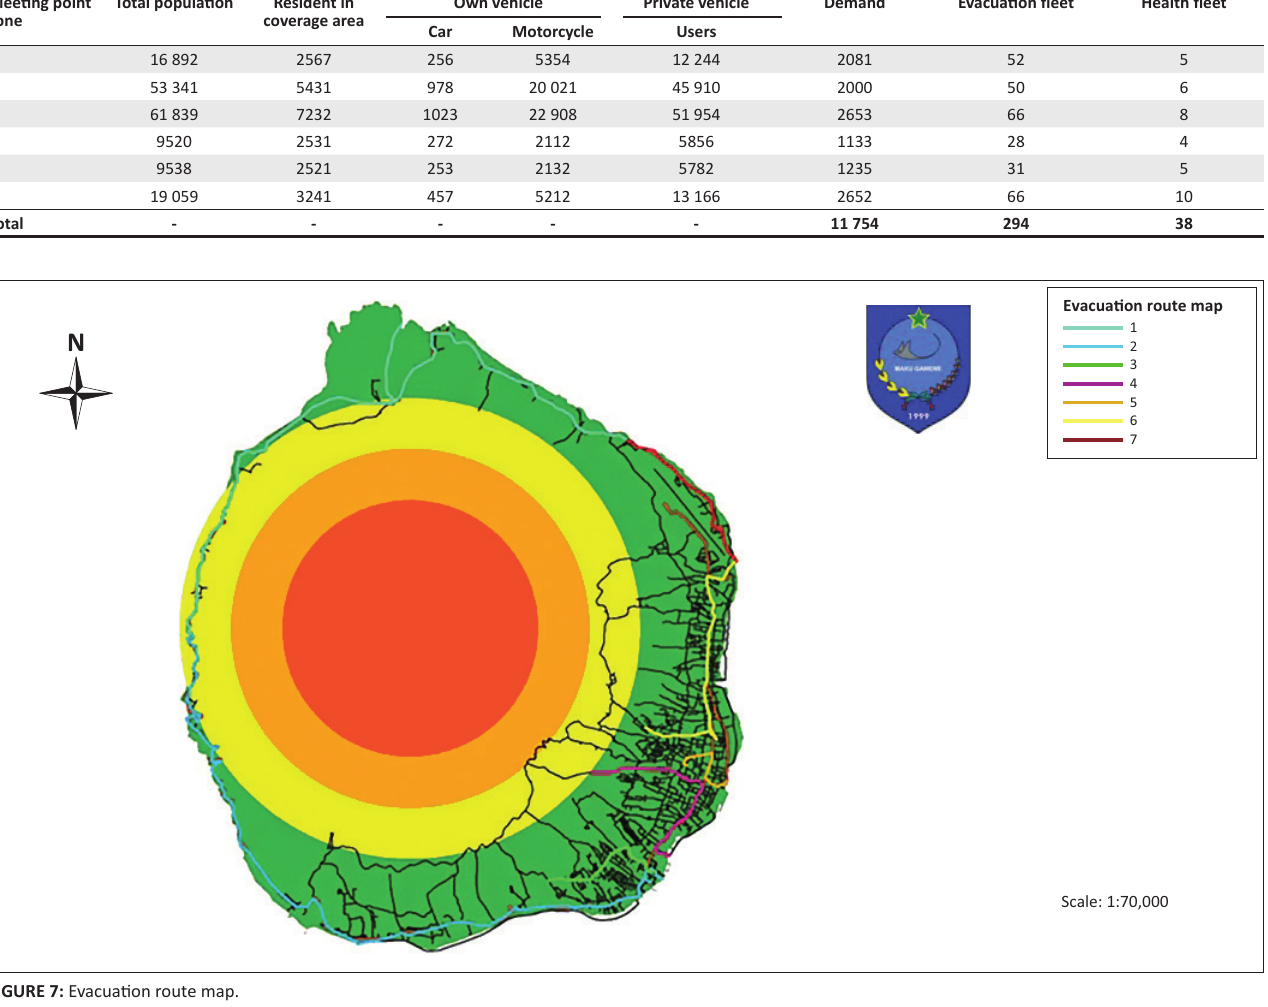
TABLE 2 : Fleet requirements. Meeting point